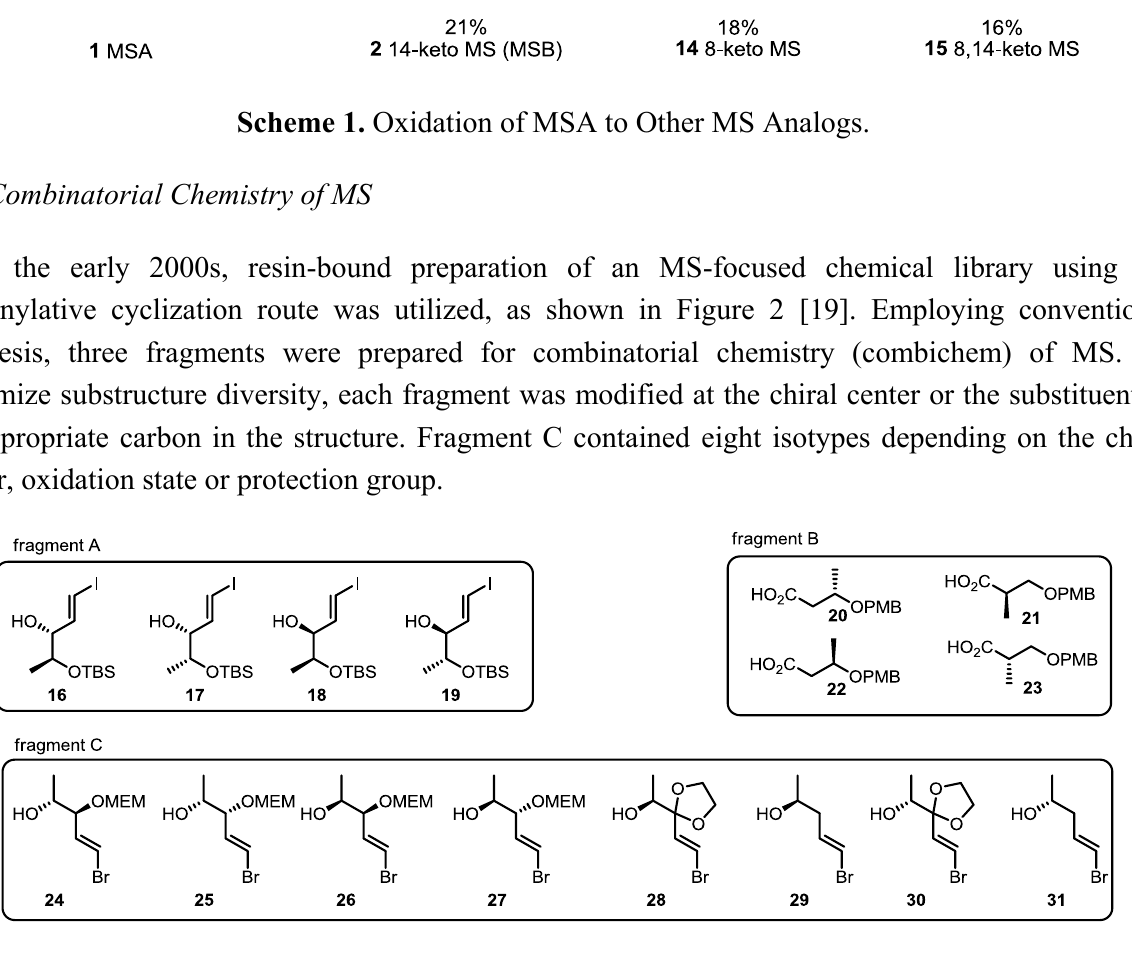
Figure 2. Fragments for the Combichem Approach of